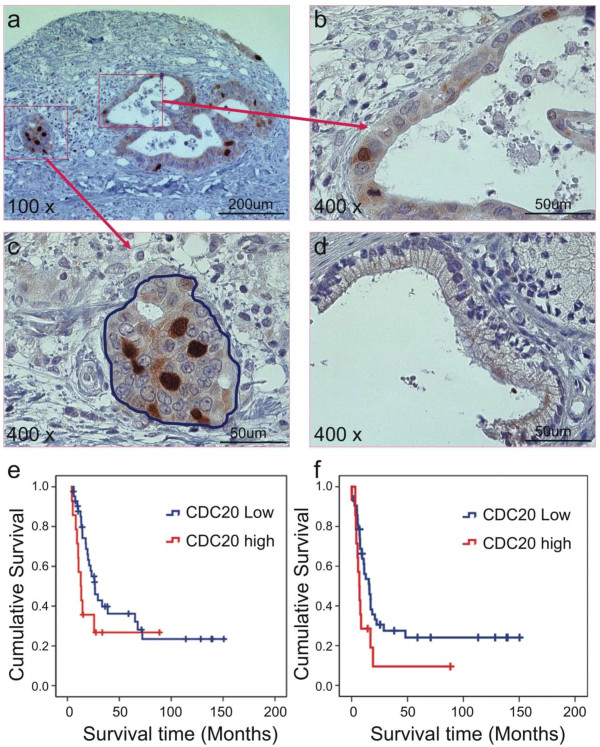
Association between CDC20 expression and PDAC patient survival. (a) A human PDAC tissue microarray was stained with anti-CDC20 antibody (100×). (b) Well-differentiated malignant pancreatic duct with positive CDC20 signaling (400×). (c) Poorly differentiated PDAC tissue with positive CDC20 signaling (400×). (d) Benign duct with negative CDC20 signaling 400×. (e) CDC20 expression was not associated with overall survival in PDAC patients. (f) CDC20 expression was associated with recurrence-free survival in PDAC patients. Upper curve, patients with low CDC20 expression; lower curve, patients with high CDC20 expression.